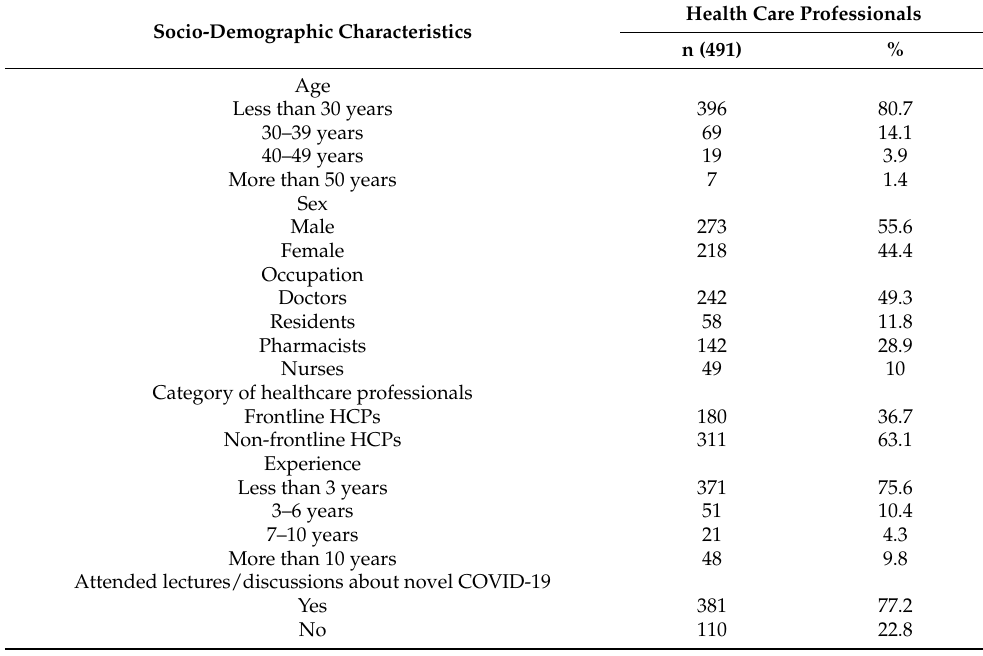
Table 1. Distribution of healthcare professionals according to their socio-demographic characteristics.